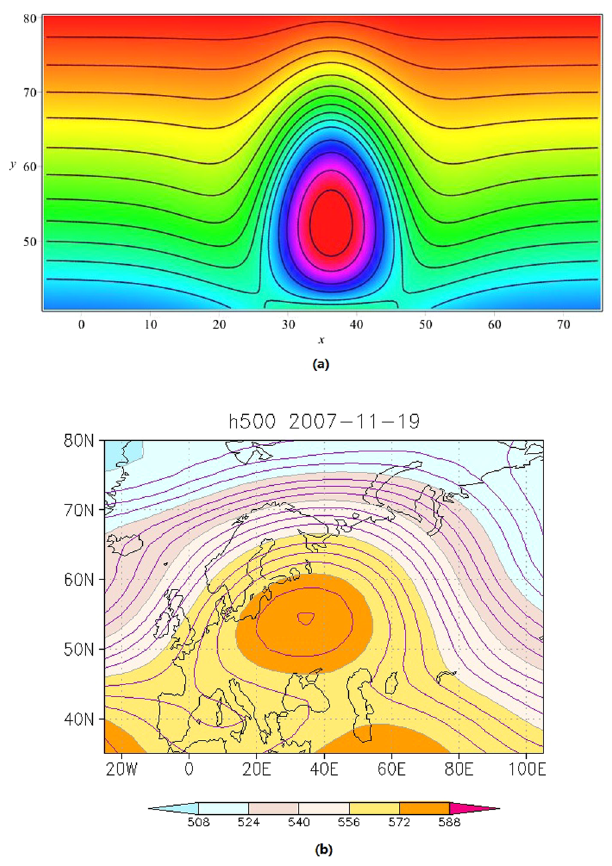
Figure 1. Theoretic result of A-event ( a ) described by ψ 1 of (51) and the corresponding real weather chart ( b ) of geopotential height at 500 hPa on 19th November, 2007 from NCEP/NCAR reanalysis data. The contour interval is 4 gpdm in ( b ), which is generated by using the charge-free software GrADS 2.0 download at http://